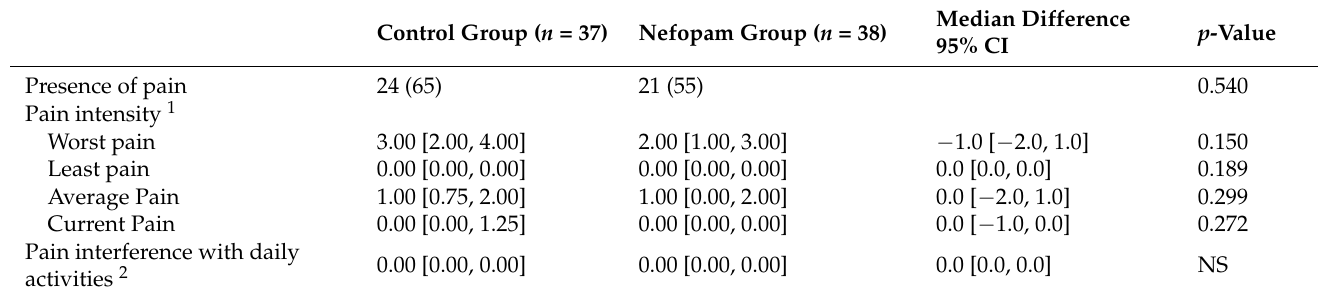
Table 4. The short form of brief pain inventory on 3 months after